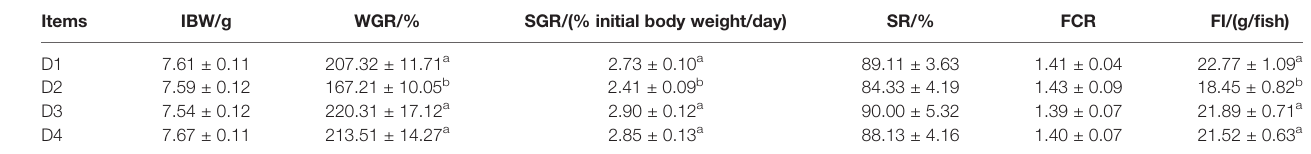
TABLE 3 | Effects of L-carnitine on growth performance of Trachinotus ovatus . Items